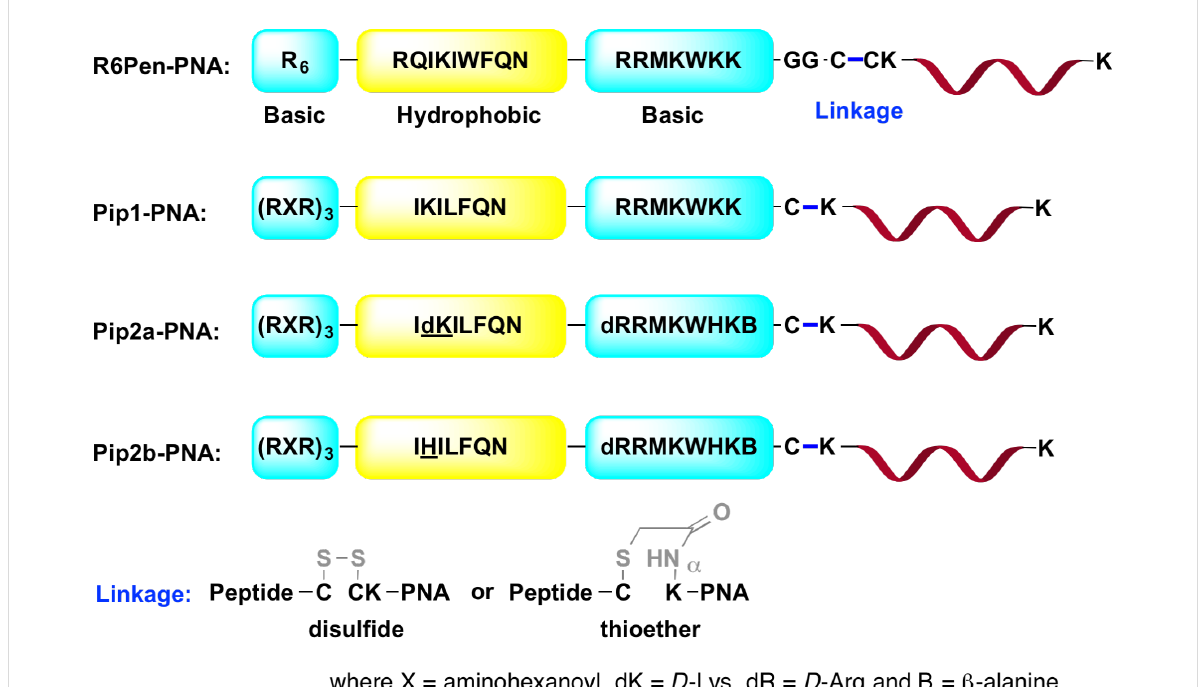
Figure 14: Structures of modified penetratin CPP conjugates with PNA linked through either disulfide (for study in HeLa pLuc705 cells) or thioether bonds (for study in cultured mdx mouse myotubes or mouse model).